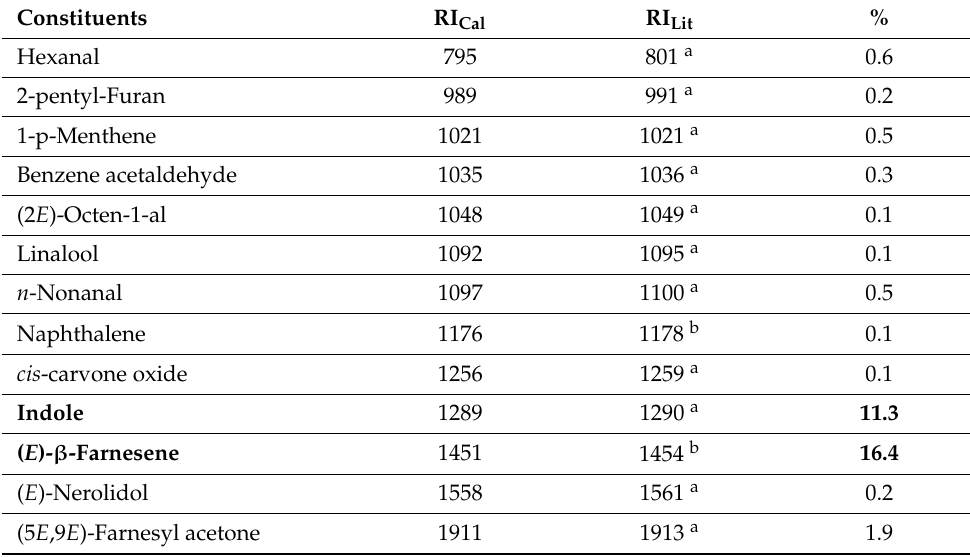
Table 3. Constituents identified in the volatile concentrate of C. barbatum